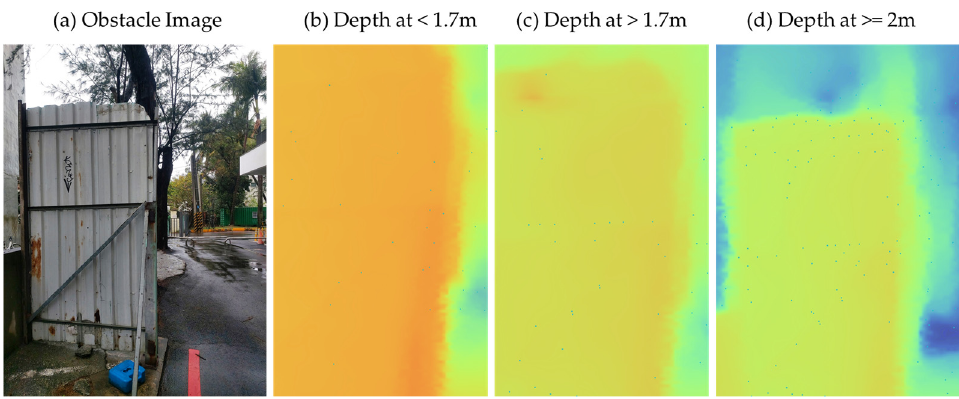
Figure 9. Depth map comparison of fan obstacle at different distances.